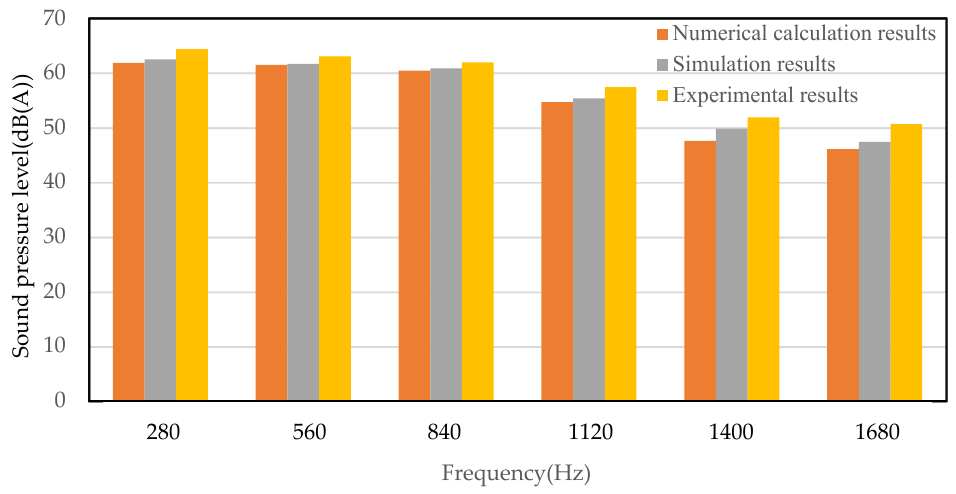
Figure 14. Numerical calculation comparison of single fan discrete noise with simulation and experimental results.